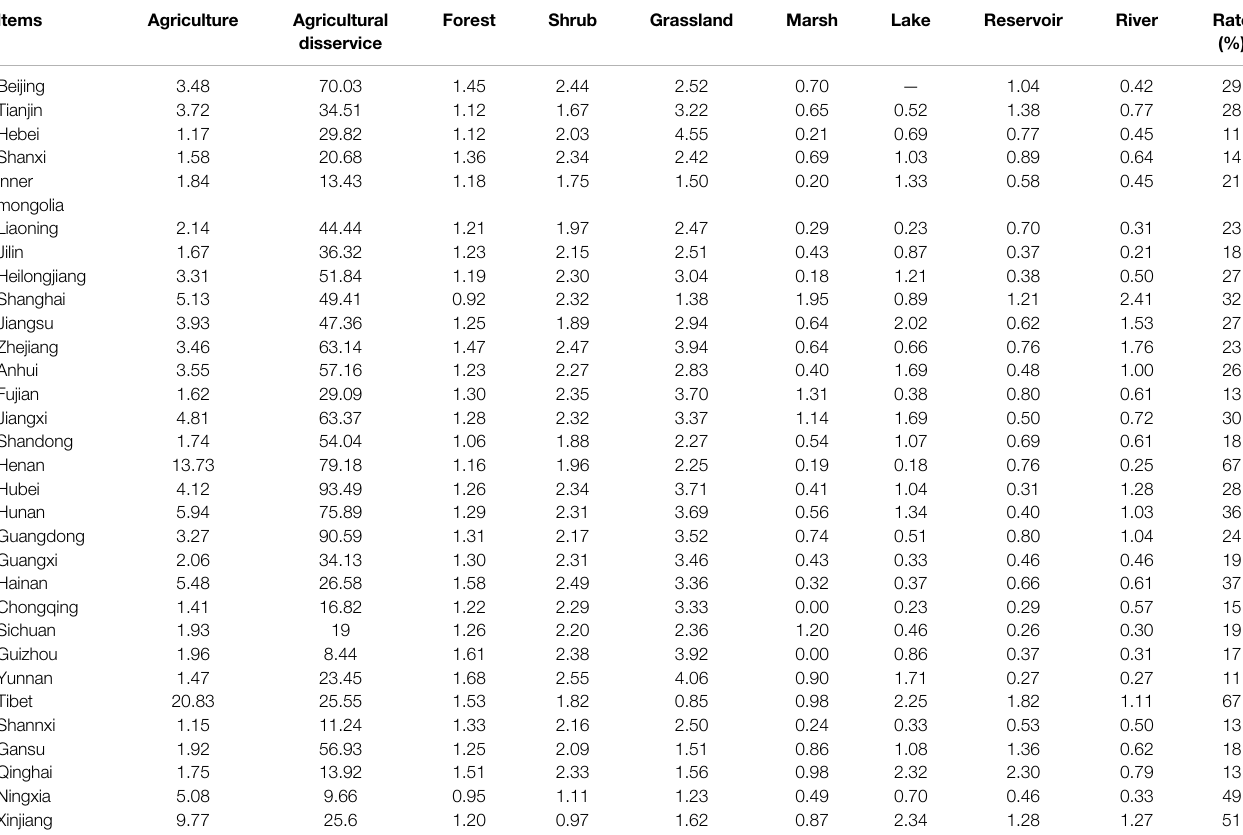
TABLE 7 | Ecosystem service value of different ecosystem. Items Agriculture Agricultural